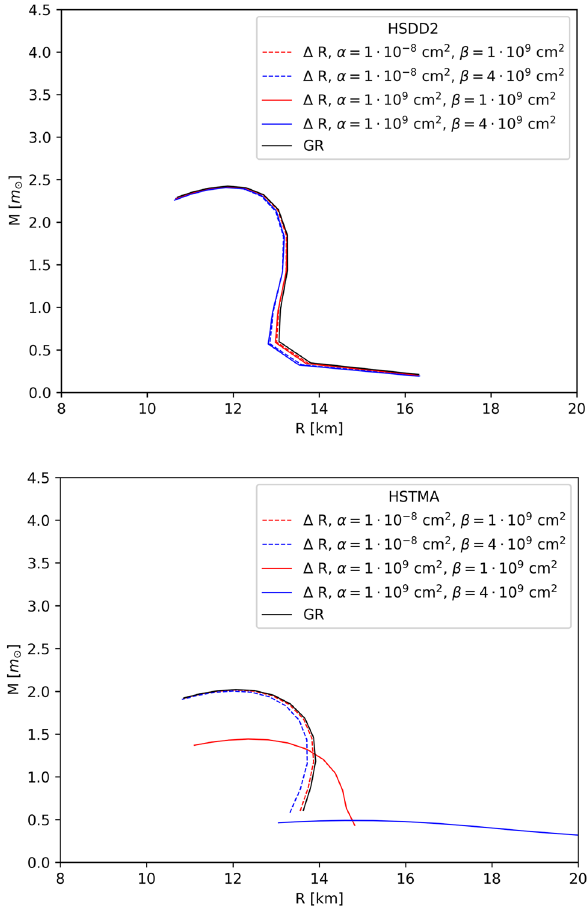
Fig. 13 Mass-radius relation for f ( R , Q ) = R + α R 2 + β Q for HS(DD2) (upper panel) and HS(TMA) (lower panel) EoS